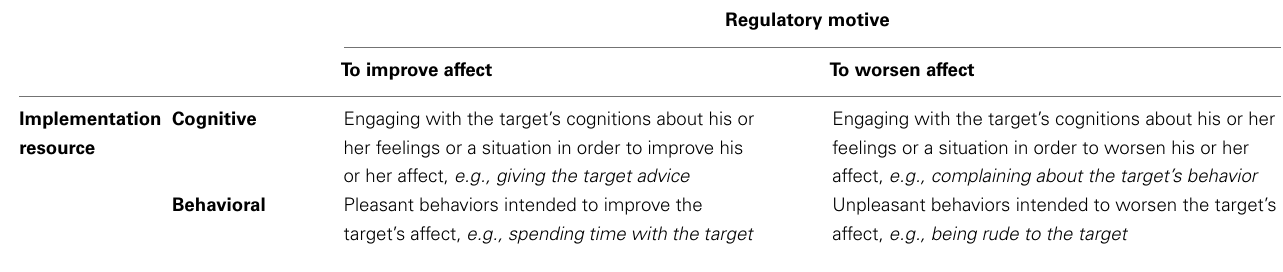
Table 1 | Interpersonal emotion regulation strategy